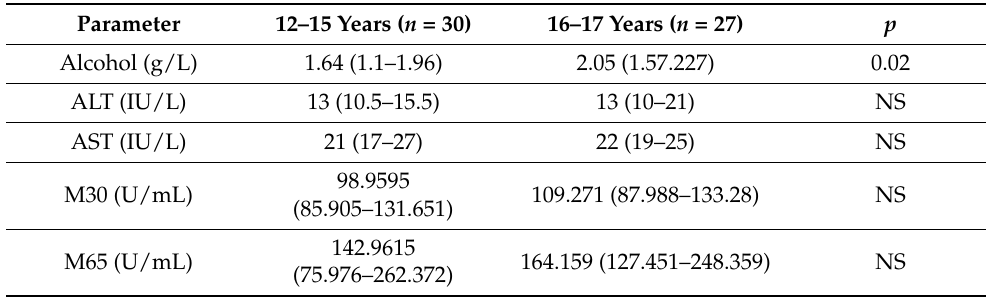
Table 3. Characteristics of the study group in terms of age: alanine aminotransferase (ALT), aspartate aminotransferase (AST), not significant